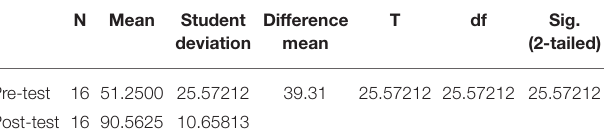
TABLE 5 | Study 1. A comparison of the performance of children before training (pre-test) and after training (post-test). N Mean Student Difference T df Sig. deviation mean